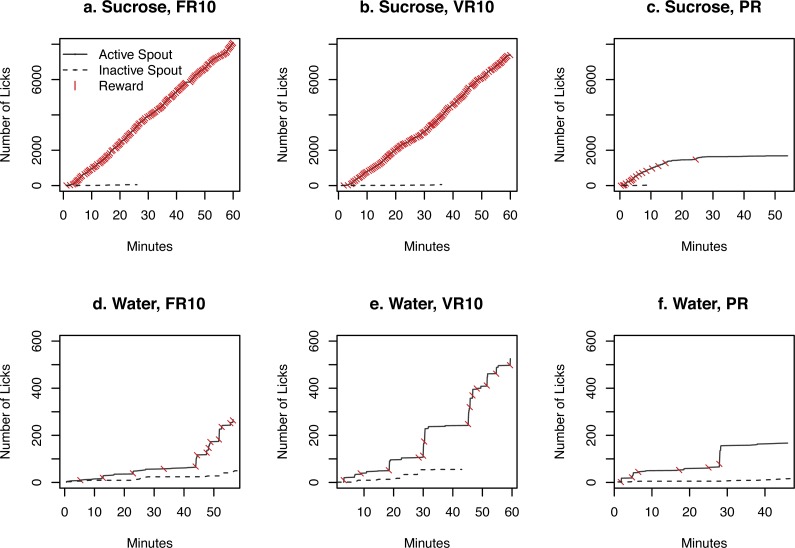
Time course of licks and rewards.The cumulative number of licks by one rat on the active and inactive spouts as well as rewards (i.e., 60 µl sucrose solution or water) earned during one test session are shown. A rat licked continuously on the active spouts for sucrose when the FR10 or VR10 schedule was used. The rate of licking slowed down dramatically under the PR ratio, where the workload for each subsequent reward increased rapidly. The rate of licking was much lower when water was provided.